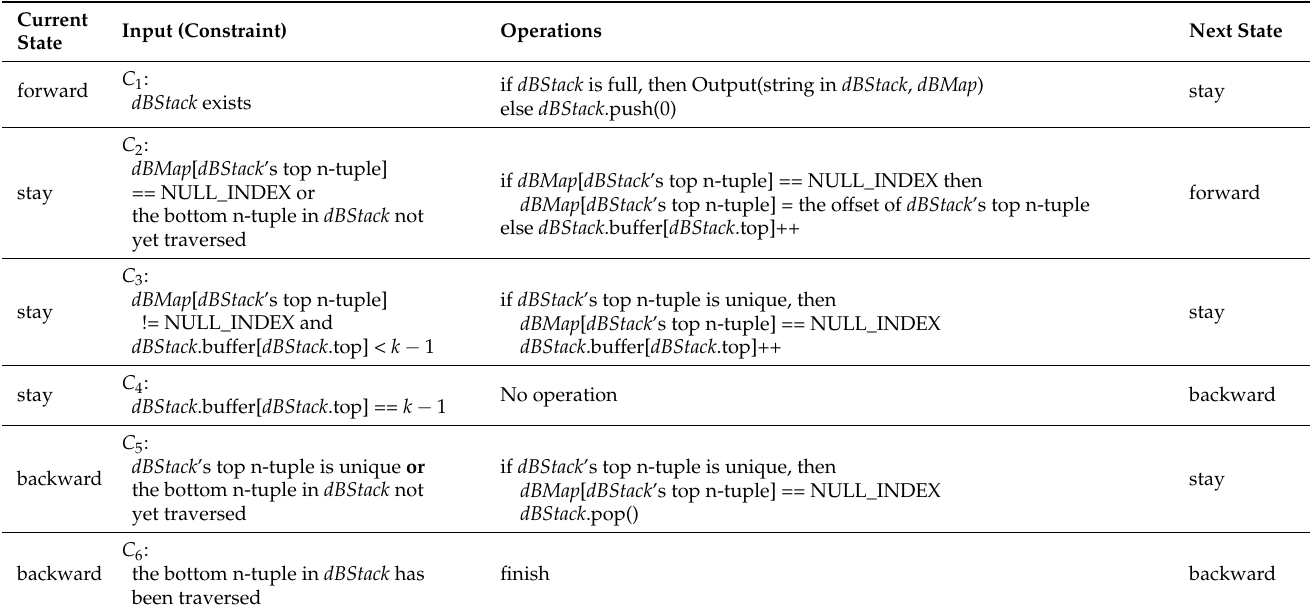
Table 1. Shift rule